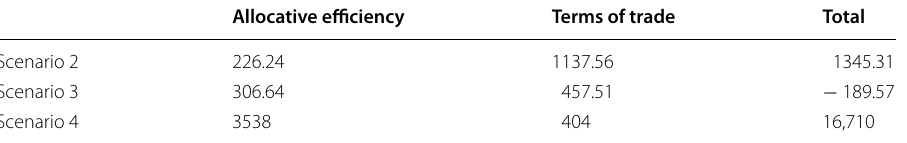
Table 9 Welfare impact on Canada in million USD (without